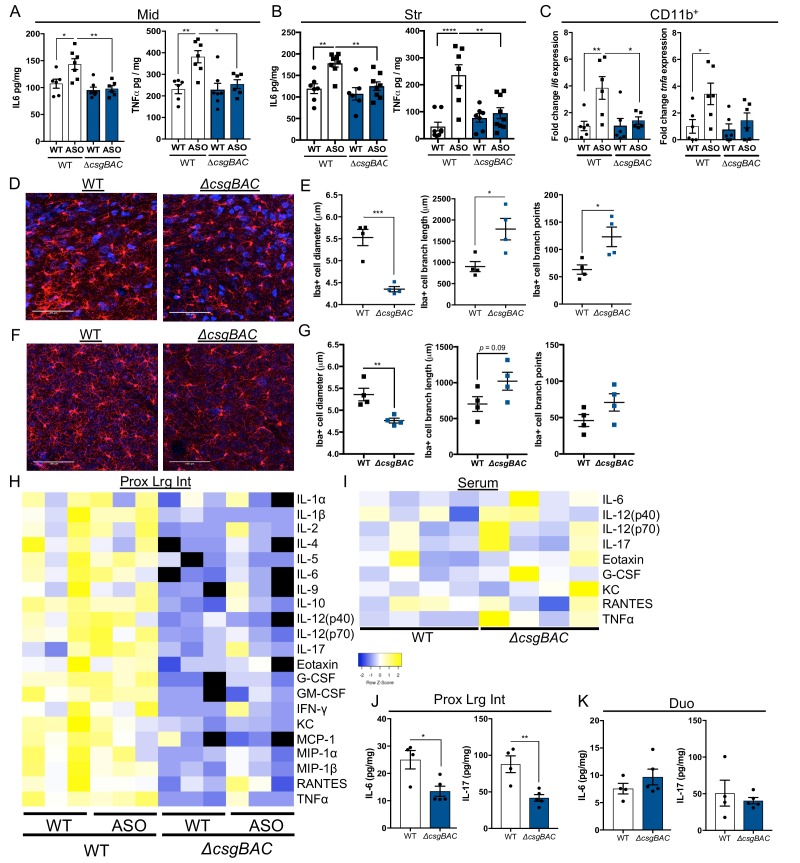
Mono-colonization with curli-sufficient bacteria induces altered inflammatory responses in the brain and intestine.Germ-free (GF) wild-type (WT) or Thy1-αSyn (ASO) animals were mono-colonized with either wild-type, curli-sufficient E. coli (WT) or curli-deficient E. coli (ΔcsgBAC). Quantification of IL-6 and TNFα by ELISA from homogenates derived from the (A) midbrain or (B) striatum. (C) CD11b+ cells enriched from total brains and gene expression of il6 and tnfa quantified by qRT-PCR, relative to gapdh. Representative thin sections of (D) substantia nigra and (F) striatum derived from ASO mice stained for Iba1 (microglia). 3D cellular reconstructions of microglia generated and morphological characteristics quantified of (E) substantia nigra- and (G) striatum—resident microglia. Multiplex ELISA performed for cytokines and chemokines derived from (H) homogenates derived from proximal large intestine tissue of indicated animals or (I) serum of ASO animals. Quantification of IL-6 and IL-17 by ELISA from tissue homogenates of the (J) proximal large intestine or (K) duodenum derived from ASO animals. n = 6–7 (A–C), n = 4 (D–G) (averaged from 20 to 40 cells for diameters, or 5–7 cells for branching), n = 3 (H), n = 4–5 (J, K). Points represent individuals, bars represent the mean and standard error. Data analyzed by one-way ANOVA with Tukey post-hoc test for A–C), or two-tailed t-test for E, J) and K). *p≤0.05; **p≤0.01; ***p≤0.001; ****p≤0.0001. Scale bars = 100 μm.Figure 1—figure supplement 3—source data 1.Source data and statistical analysis.